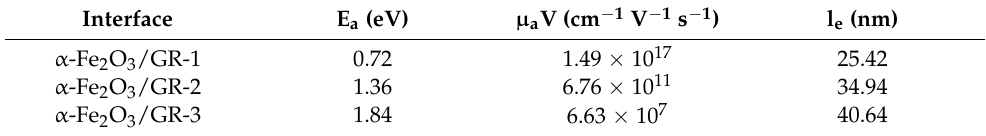
Table 3. Conduction parameters at the α -Fe 2 O 3 /graphite interface under alternating current injection.